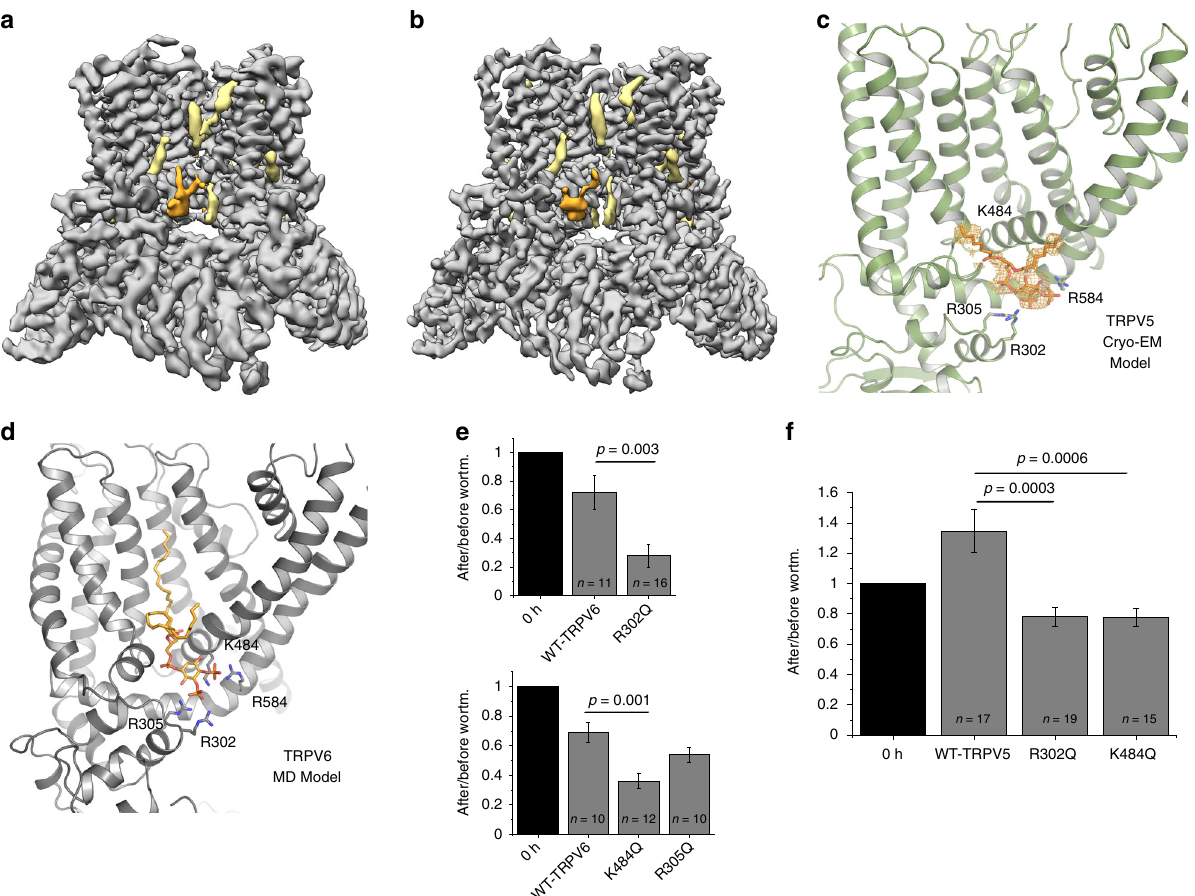
Fig. 2 PI(4,5)P 2 -bound TRPV5 structure and PI(4,5)P 2 -bound TRPV6 modeling. a The initial reconstruction of PI(4,5)P 2 -bound TRPV5 in nanodiscs before masking and 3D classi fi cation. TRPV5 density is shown in gray, annular lipids are shown in khaki, and PI(4,5)P 2 is shown in orange. b PI(4,5)P 2 -bound TRPV5 cryo-EM density in nanodiscs after focused 3D classi fi cation. TRPV5 density is shown in gray, annular lipids are shown in khaki, and PI(4,5)P 2 is shown in orange. c Zoomed-in view of the TRPV5 PI(4,5)P 2 -binding pocket. The PI(4,5)P 2 -binding site in the TRPV5 channel is located between the N-linker (R302, R305), S4-S5 linker (K484), and the S6 helix (R584) of the channel. d A model produced by molecular dynamics (MD) simulations of